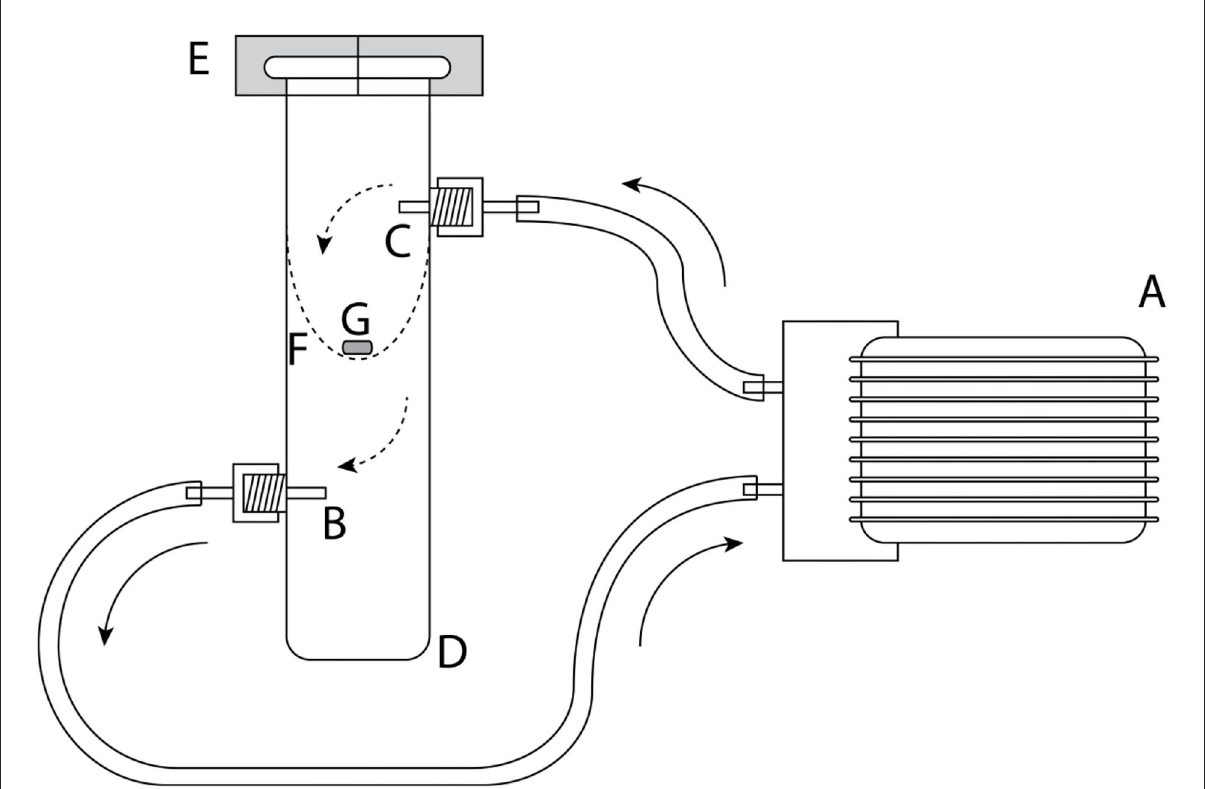
FIGURE1 Experimental setup for measuring emission rates for different volatile organic compounds. (A) Airpump, (B) Tenax ® TA filled glass tube, (C) air filter filled with activated charcoal, (D) glass cylinder, (E) polytetrafluoroethylene (PTFE) clasps, (F) metal grid for holding, and the (G) silicone septa. Arrows indicate the direction of